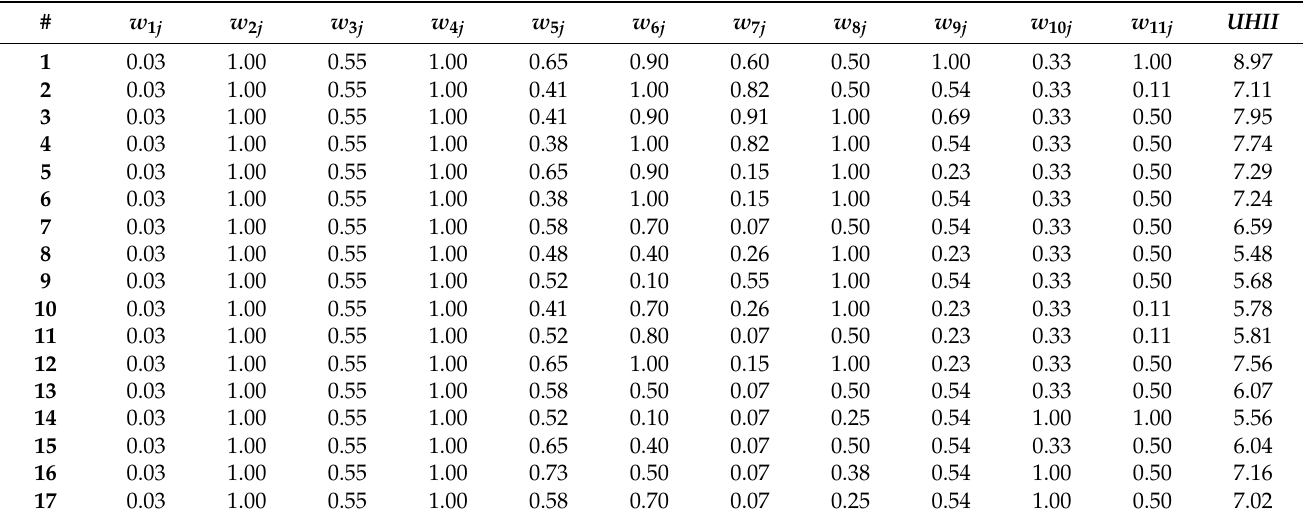
Table 4. Values of w ij weights and UHII per each district of